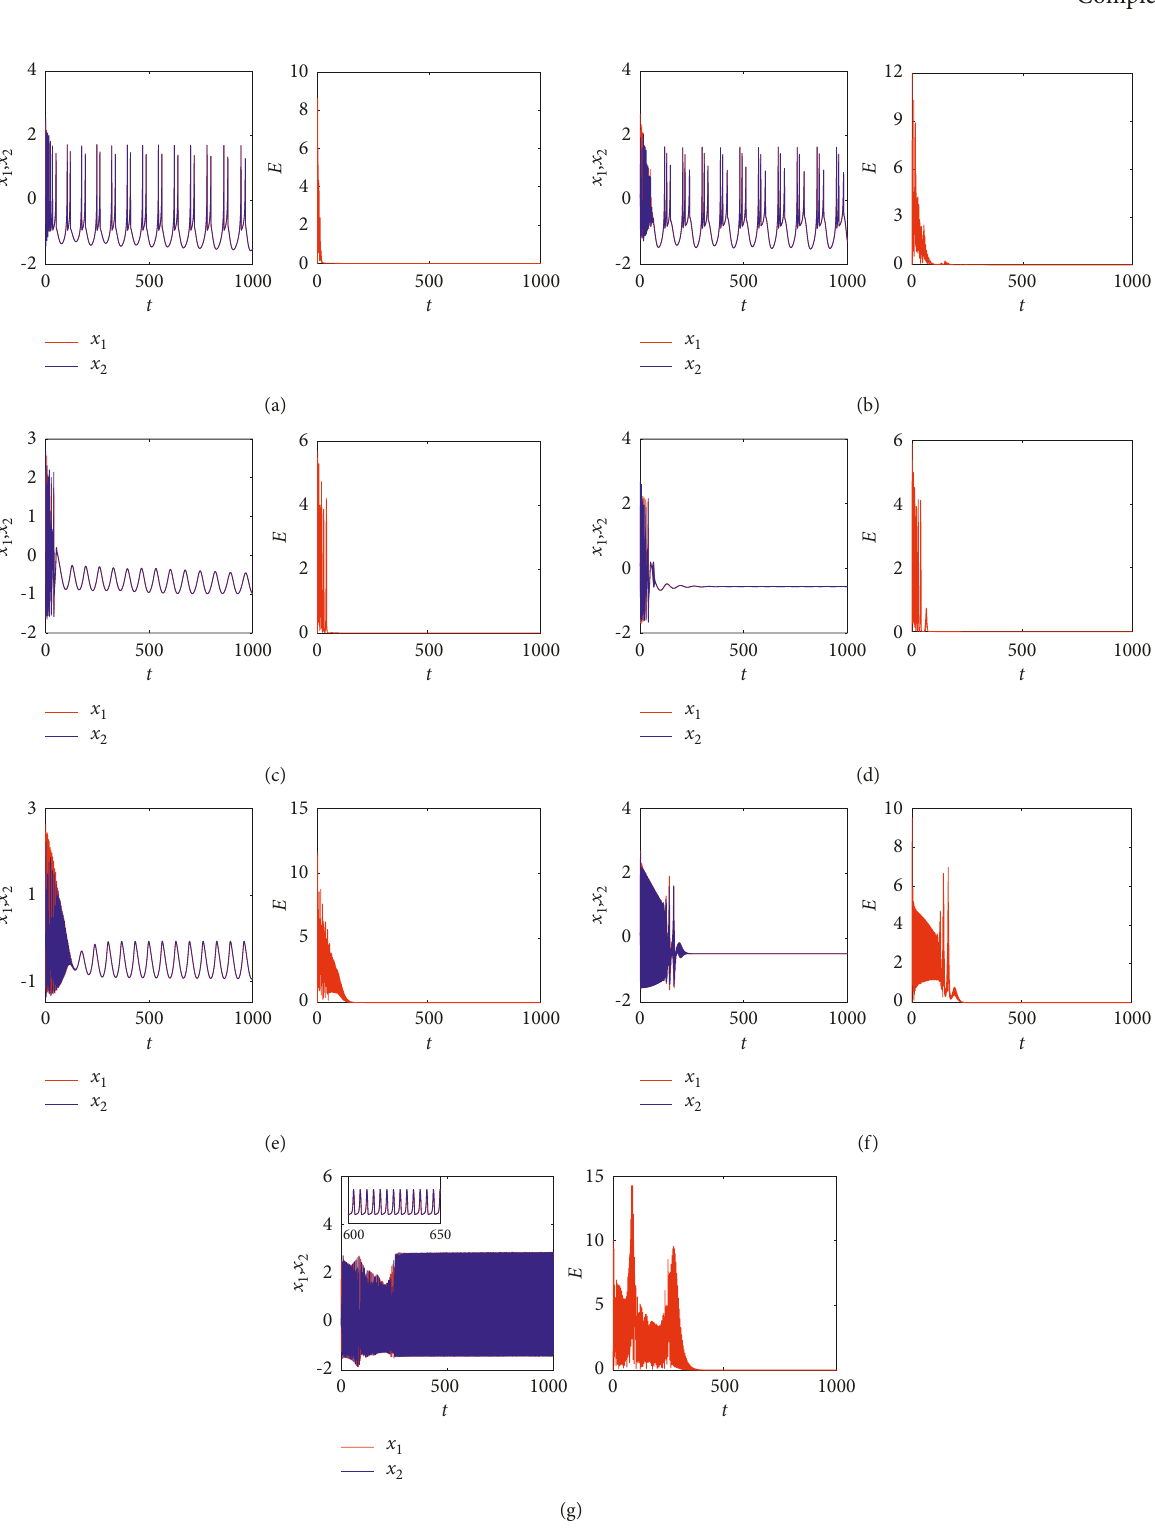
Figure 12: The time series of membrane potentials x (red line) and x (blue line), and error functions of the coupled model at case 3 1 2 (periodical and quiescent neurons). For (a) bursting firing synchronization with τ � 0 . 01 and D � 5; (b) bursting firing synchronization with τ � 0 . 1 and D � 1 . 5; (c) spiking firing synchronization with τ � 0 . 1 and D � 11; (d) quiescent state synchronization with τ � 0 . 1 and D � 13; (e) spiking firing synchronization with τ � 0 . 5 and D � 2; (f) quiescent state synchronization with τ � 0 . 5 and D � 5; and (g) periodical firing synchronization with τ � 3 and D � 4. The initial values are selected with (0.1, 0.01, 1.05, 0.1, 0.01,